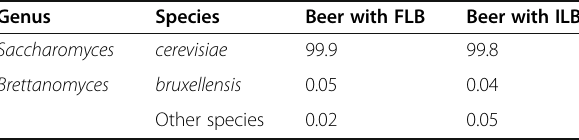
Table 2 Relative abundance of fungi in beer with FLB and ILB at the species taxonomic level